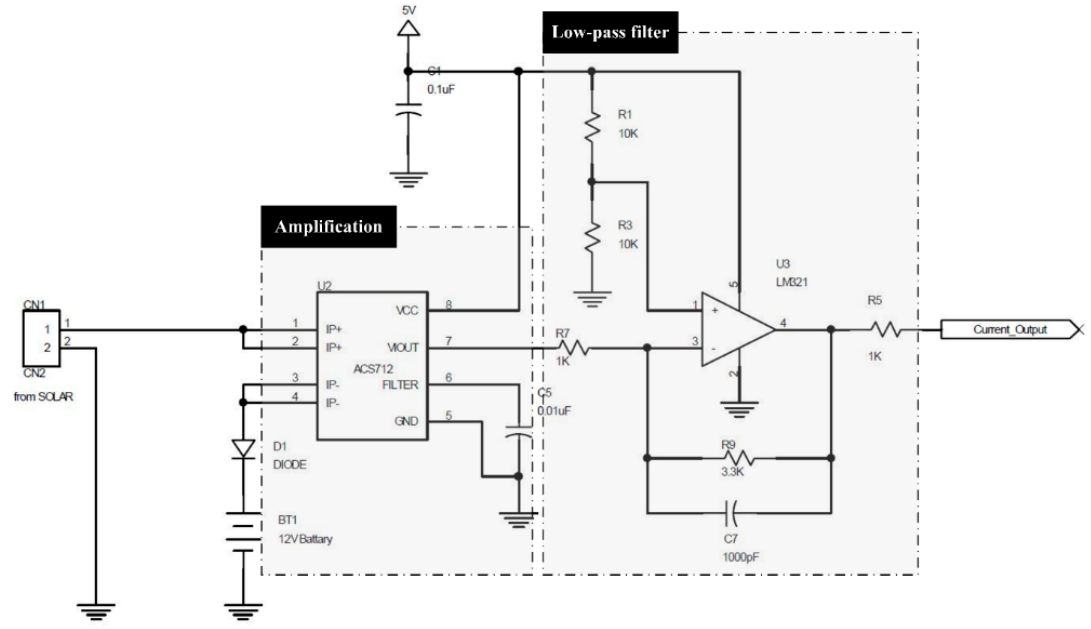
Figure 5. Schematic circuit for measuring the amount of electricity generated from the SPSB.